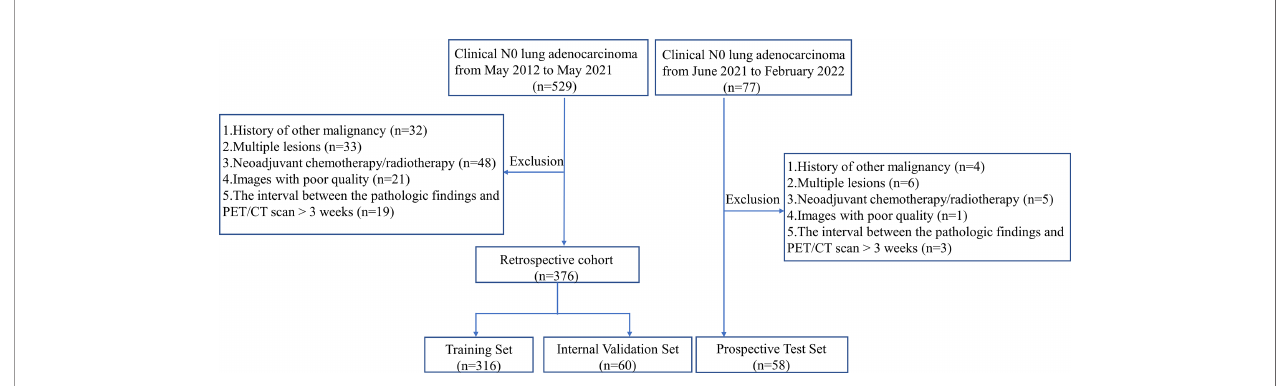
FIGURE 1 | The fl owchart of the patient